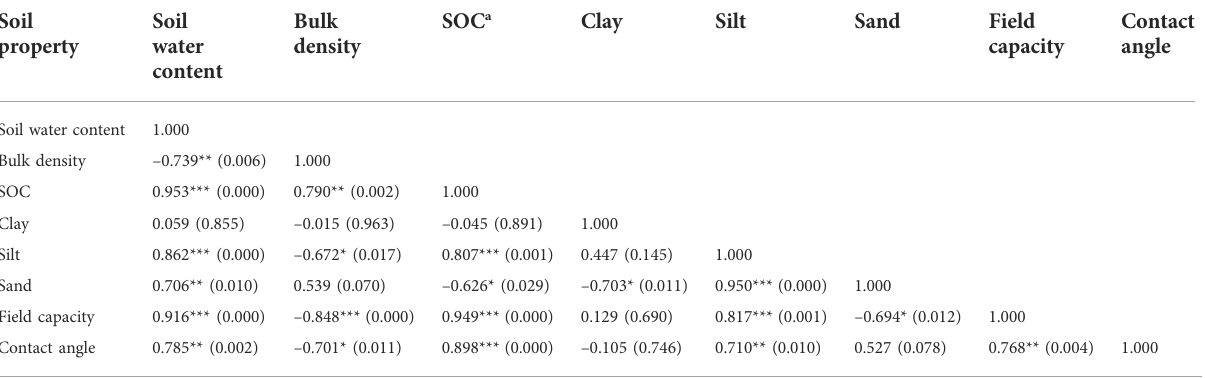
TABLE 3 The correlation coef fi cient and signi fi cance (in brackets) from Pearson correlation matrix for soil